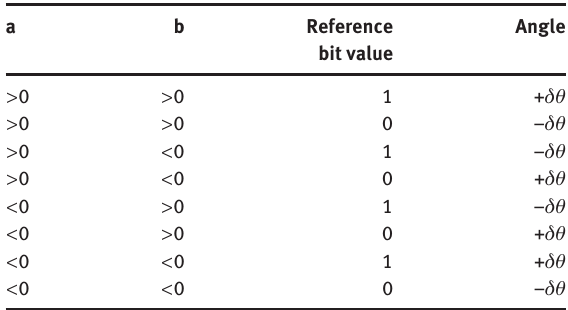
Table 2. Lookup Table of the Rotation Angle.